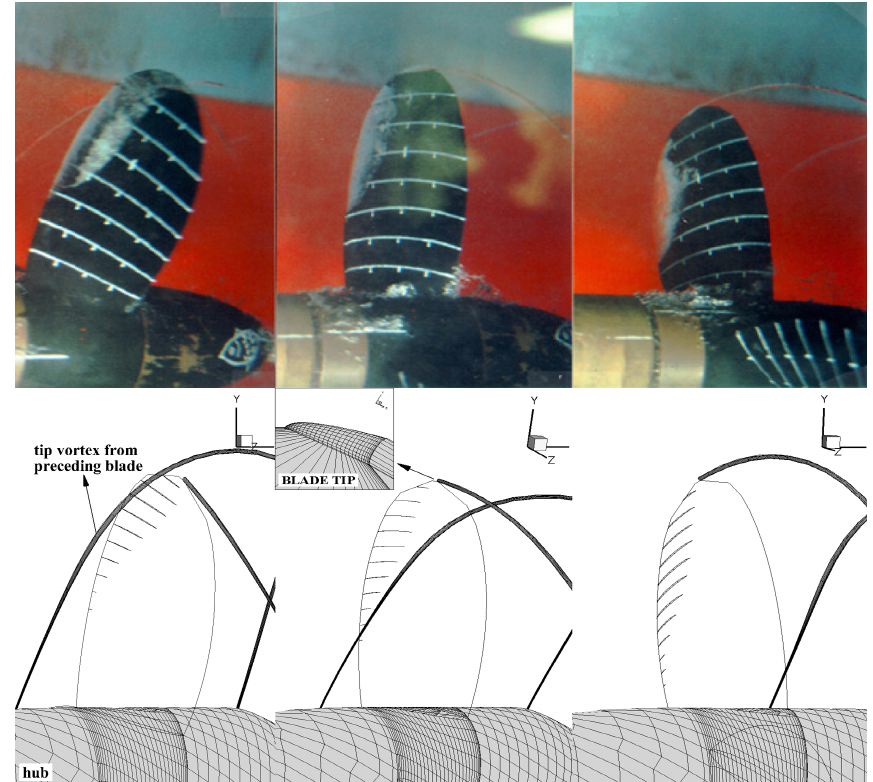
Figure 19. Comparisons of the blade sheet and tip vortex cavities predicted by the present method ( bottom ) with the measurements ( top ) for DTMB N4148 propeller: J S = 0.9087, F n = 9.159, and σ n =